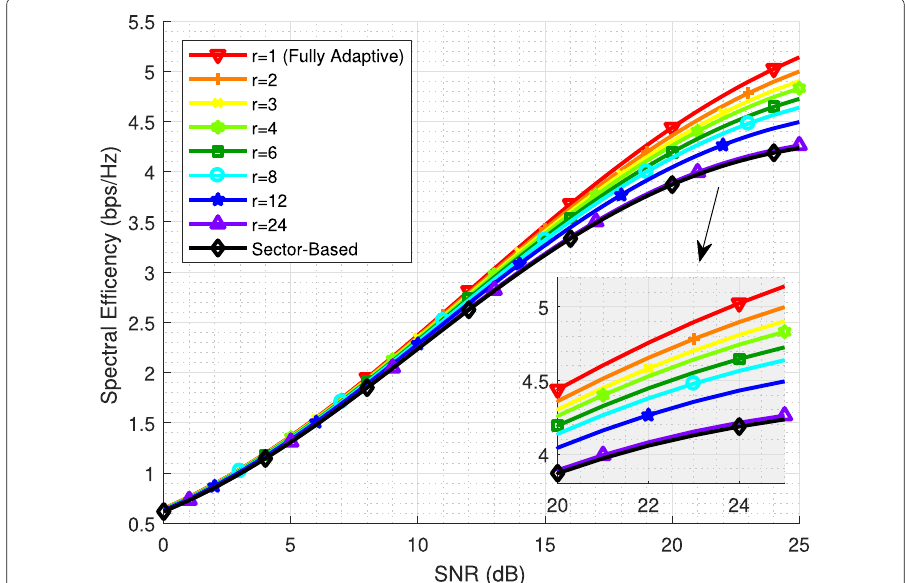
Fig. 12 Numerical results for one user per frame (unicast mode) and different outer precoder refreshment